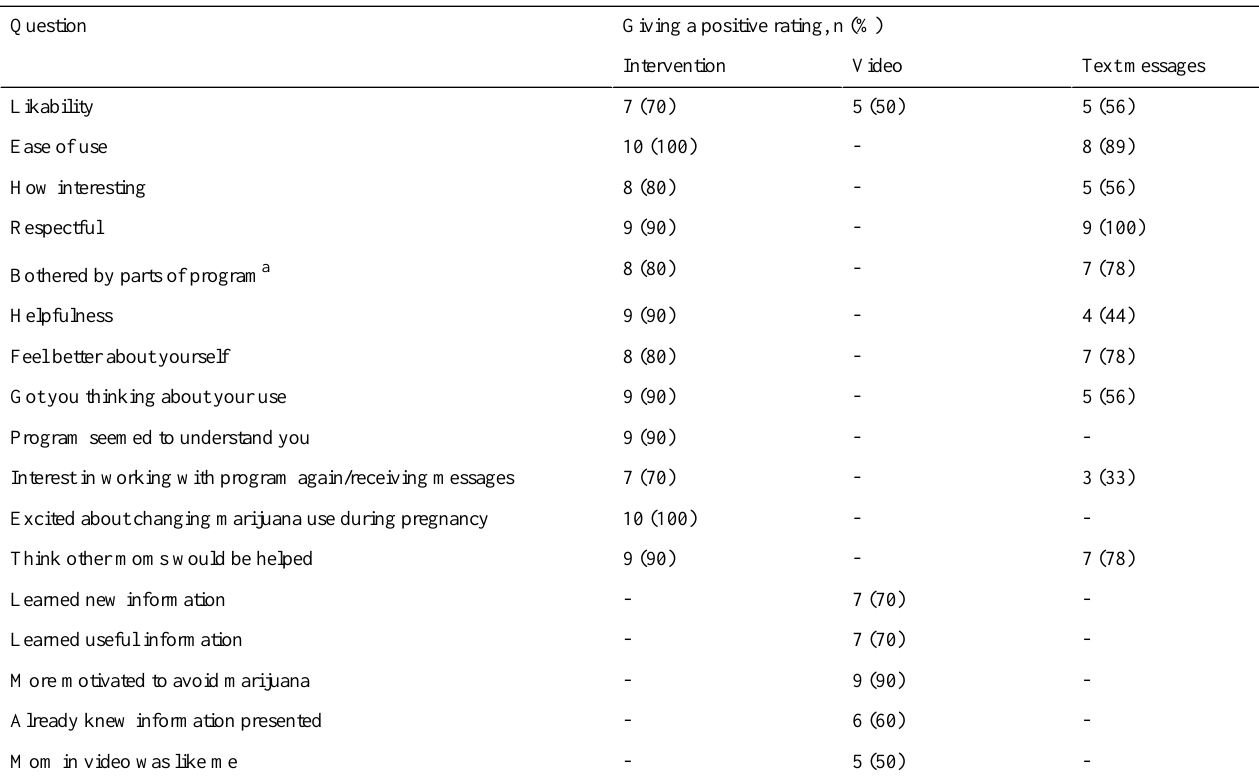
Table 1. Quantitative ratings of software, video, and short message service (SMS) acceptability (scored on a 5-point Likert scale, with 1=not at all and 5=very much; positive rating=score of 4 or 5; n=10 for intervention and video ratings, n=9 for text message ratings). Giving a positive rating, n